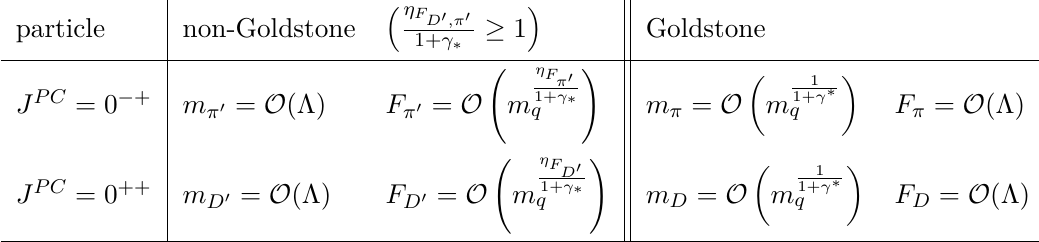
. The behaviour of m and F QCD D,π D 0 ,π 0 is ∗